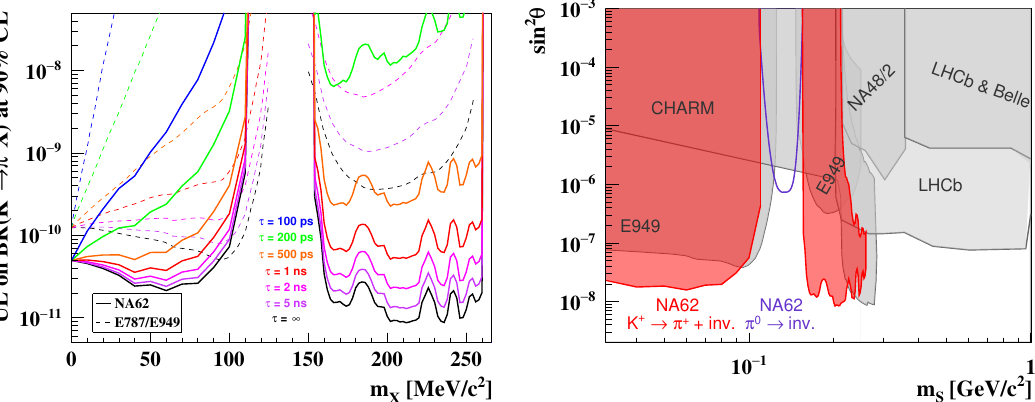
Figure 8 . Left: expected and observed number of events as a function of the reconstructed m 2 for the 2018 data set. Right: upper limits on BR( K + → π + X ) for each tested m obtained for the full 2016–2018 data set.